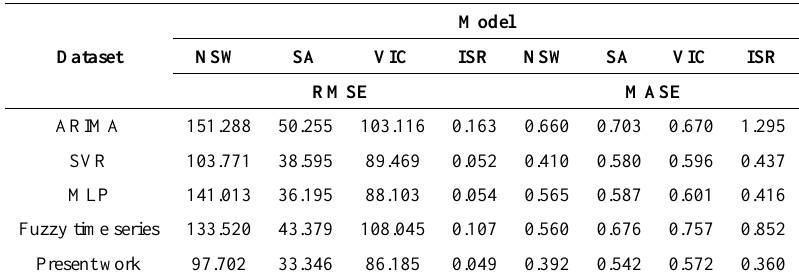
Table 1. Comparison with Classical Models by RMSE and MASE Criteria